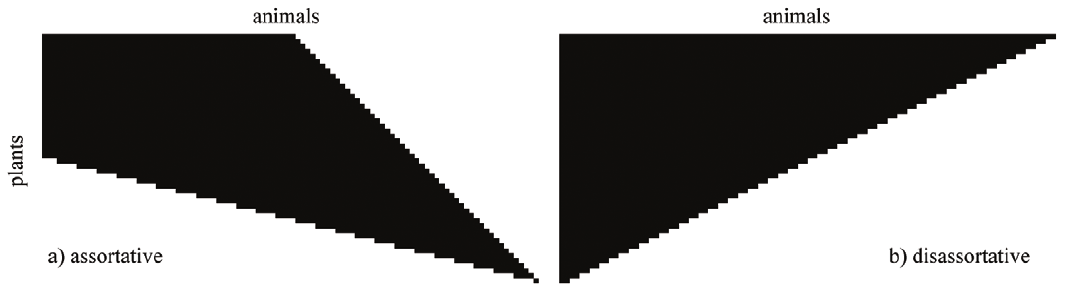
Figure 1. Assortative and disassortative interaction networks of bipartite systems. 50 plants (rows), 100 animals (columns). A black dot represents an interaction between the corresponding plant and animal. a) Assortative system (rhomboid model) with r ~ 0 : 59 ; tends to connect generalist to generalist and specialist to specialist. b) The disassortative system (triangle model), r ~{ 0 : 5 , instead, tends to connect specialist to generalist. This last is the case sometimes called ‘‘asymmetric.’’